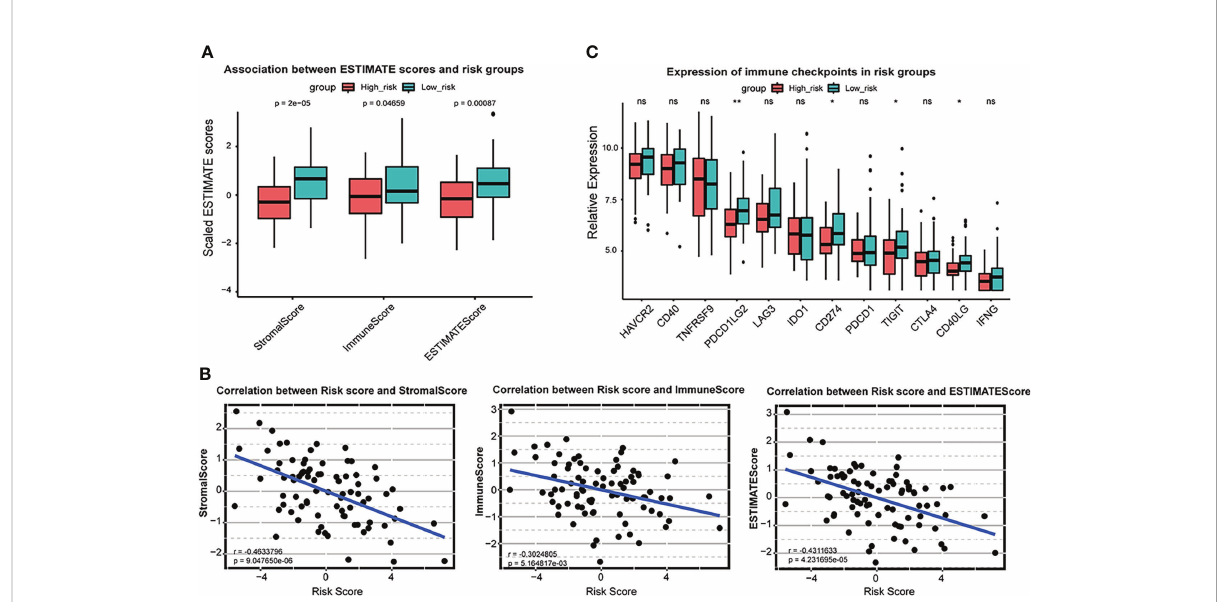
FIGURE 4 Association between ESTIMATE scores and risk scores in TARGET OS cohort. (A) Box plot of Stromal score, immune score and ESTIMATE score and in high-risk group and low-risk group. Red represents high risk group and blue represents low risk group. (B) Scatter plot shows correlation between risk score and stromal score, immune score and ESTIMATE score. (C) Box plot of relative expression of immune checkpoints in risk groups. * P < 0.05; ** P < 0.01; ns, no signi fi